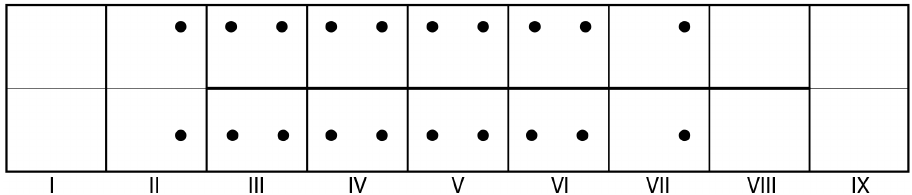
Figure 25. Lepidostoma scotti , 5 th instar larva . Gill diagram indicating position of dorsal and ventral gills and extent of lateral line (bold line). Lateral gills